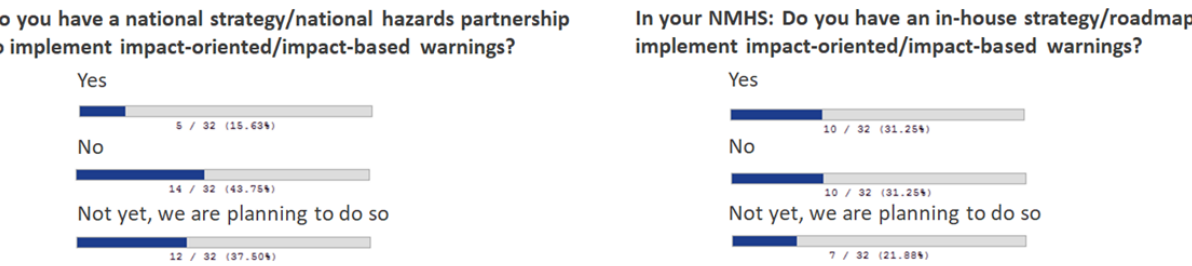
Figure 7. A majority of surveyed NMHSs currently do not have a national strategy/national hazards partnership to implement IoWs/IbWs. Slightly more NMHSs do have an in-house strategy/roadmap to implement IoWs/IbWs, others are planning to do